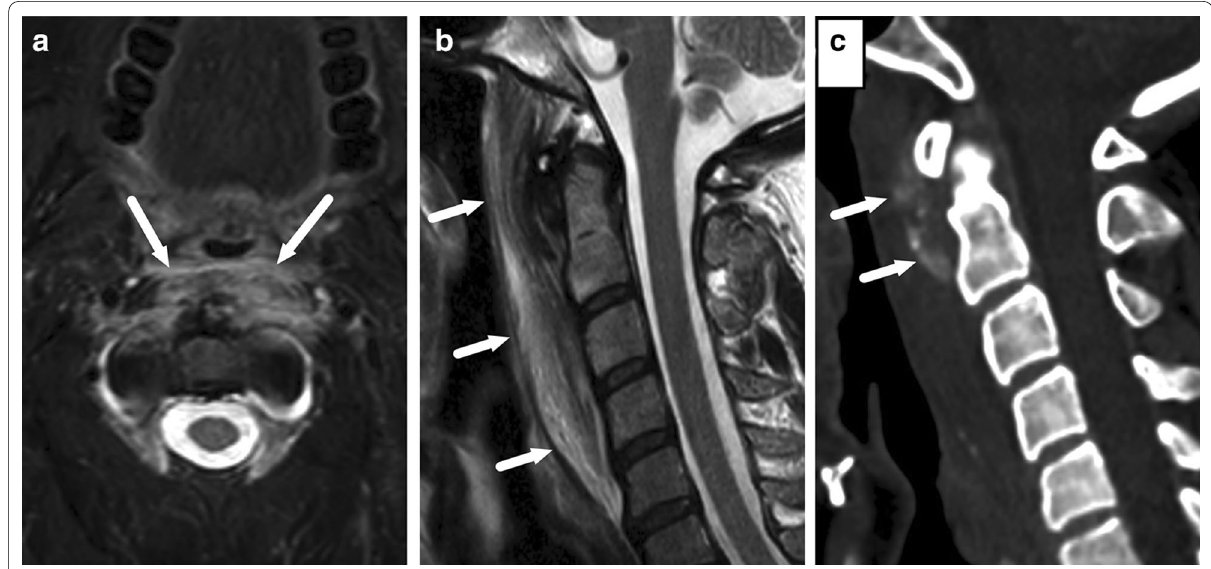
Fig. 36 Calcific tendinitis of the longus colli mimicking a retropharyngeal infection. Axial fat-suppressed T2-weighted ( a ) and sagittal T2-weighted ( b ) images show massive swelling of the longus colli muscles and retropharyngeal tissues (arrows). A sagittal non-contrast CT ( c ) shows a pathognomonic finding of amorphous calcifications of the longus colli muscle (arrows)